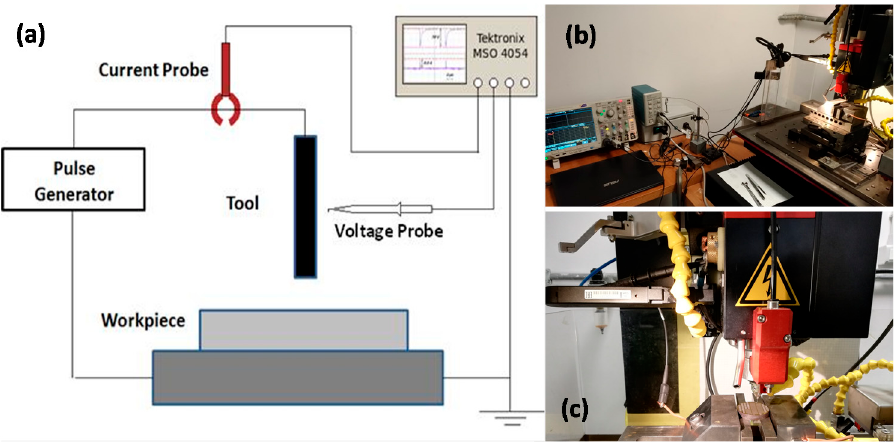
Figure 2. ( a ) Sketch of the micro-EDM monitoring setup; ( b ) actual monitoring setup connected to the Sarix SX 200 via voltage and current probes; ( c ) voltage and current probes mounted on the